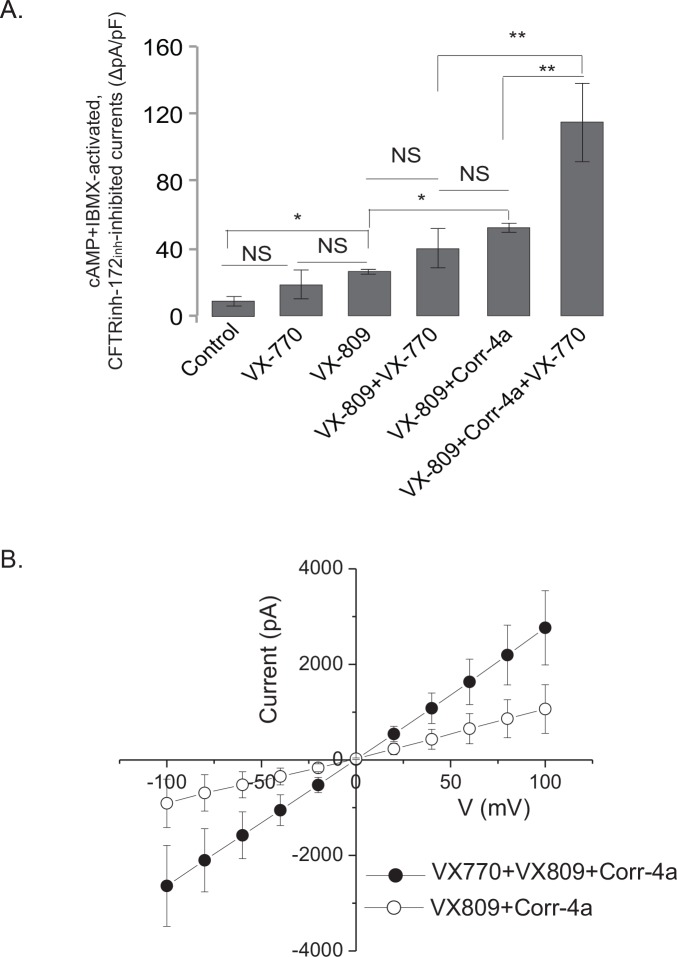
Corr-4a increases cAMP-activated, CFTRinh-172-inhibited whole-cell currents in VX-809+VX-770 treated I507-ATT ΔF508 CFTR expressing cells.Whole-cell patch clamp studies were performed following treatment with CFTR modulators as specified (5μM VX-809 + 10μM Corr-4a+ 5μM VX-770, 16h, 37°C). Corr-4a and VX-809 were present during recordings, but VX-770 was washed out prior to experiments. A: Results are plotted as maximum forskolin+IBMX-induced and CFTRinh-172-inhibited maximum currents (ΔpA/pF), n = 21 (Control, VX-809 and VX-809+Corr-4a), n = 13 (VX-770, VX-809+VX-770 and VX-809+VX-770+Corr-4a), *: p<0.01; **: p<0.001 by ANOVA; error bars: means± SE B: Representative I/V relationships obtained from cells treated with VX-809+Corr-4a and VX-809+Corr-4a+VX-770, n = 8, error bars: means± SE.